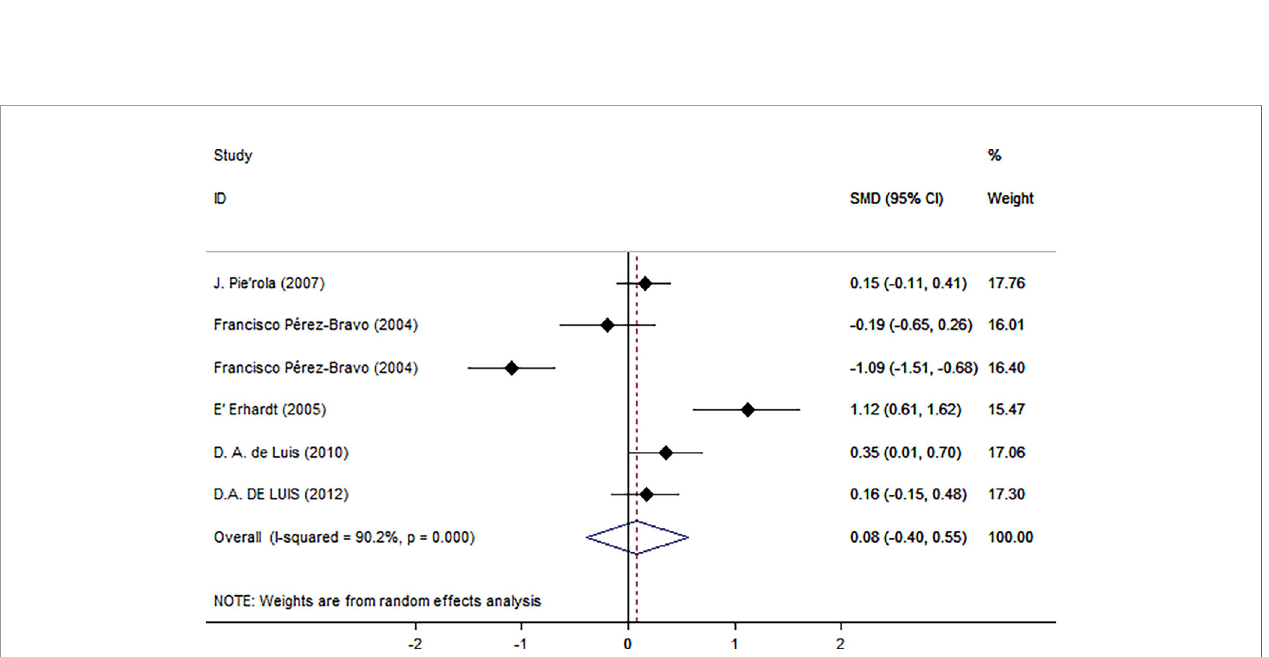
FIGURE 5 | Using HOMA as an index of insulin resistance. Forest plot showing the effect size of the correlation between Trp64Arg mutation and insulin resistance. 95% con fi dence intervals (CIs) are expressed in bars (each group) and diamond (all studies). Summary estimates are analyzed using a random-effects model. SMD, standardized mean difference.